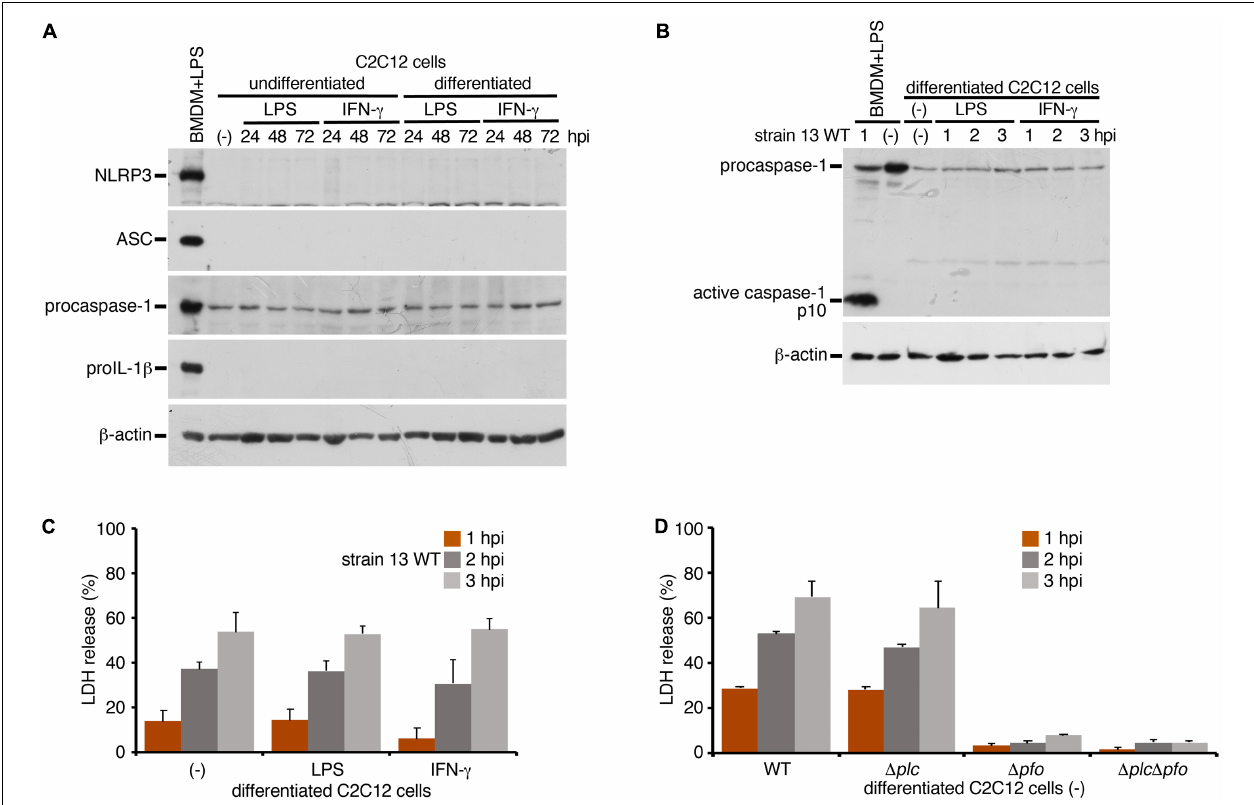
FIGURE 4 | Inflammasome activation is not induced in the infected skeletal myocytes. Mouse C2C12 myoblasts or the differentiated myocytes using horse serum was treated with LPS (1 µ g/ml) or IFN- γ (100 ng/ml) for 24 to 72 h. (A) The expression of NLRP3, ASC, procaspase-1, and proIL-1 β in the cells were analyzed by immunoblotting with anti-NLRP3, anti-caspase-1 (p10) or anti-IL-1 β antibody, respectively. (B,D) The differentiated myocytes were treated with LPS or IFN- γ for 48 h, and infected with WT C. perfringens (strain 13). The activation of caspase-1 was analyzed by immunoblotting (B) . (C) Culture supernatants of the infected myocytes were analyzed for LDH release at 1 to 3 hpi. (D) The differentiated myocytes were infected with WT C. perfringens , and/or any of its isogenic mutants, (cid:49) plc , (cid:49) pfo and (cid:49) plc (cid:49) pfo , and analyzed the LDH release from infected cells. Data are presented as the means ± SD of triplicate samples.